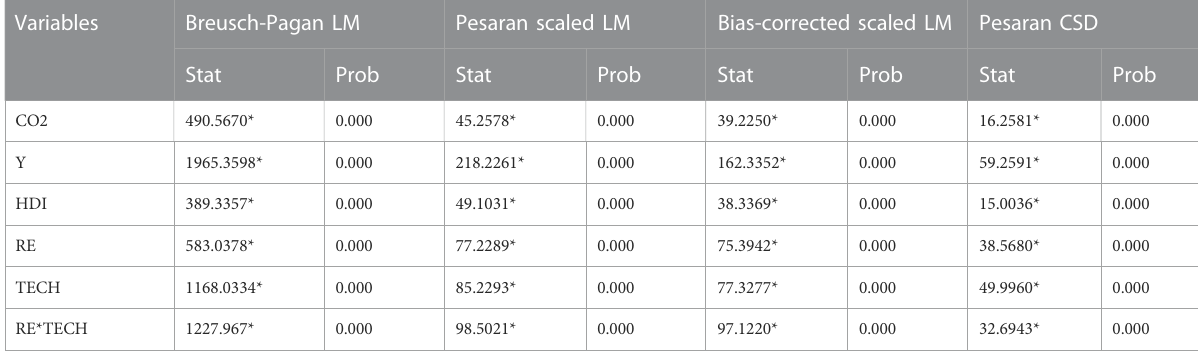
TABLE 3 CSD test